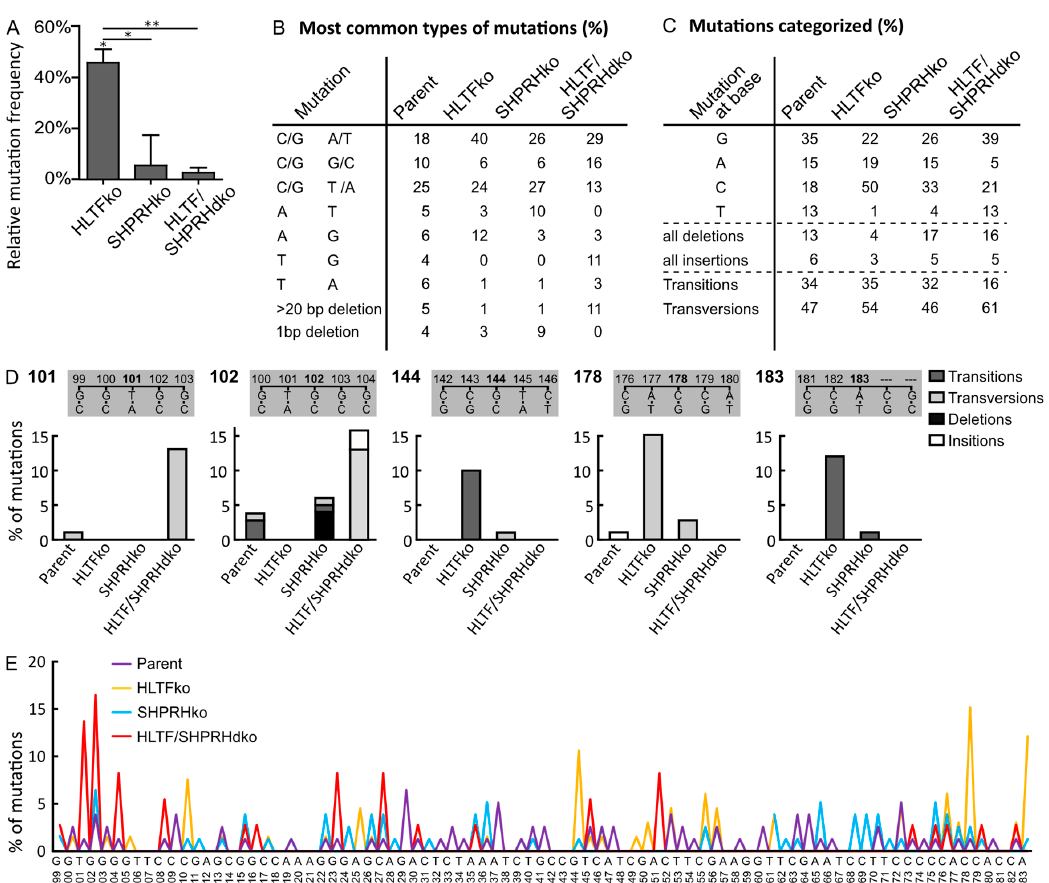
Figure 3. HLTF reduces error-prone DDT after MMS damage. ( A ) Mutation frequencies after overexpression of MMS damaged supF reporter plasmid pSP189 relative to the control (Hap1 parent cell line) with number of colonies counted for HLTF ko (n = 20,104), SHPRH ko (n = 22,294), HLTF / SHPRH dko (n = 19,130), Parent (n = 20,538), two-sided student’s t -test, * p < 0.05, ** p < 0.01. ( B ) Quantification of types of mutations from sequencing mutant colonies from ( A ) with a prevalence ≥ 5%. ( C ) Categorized mutations received from sequencing mutant colonies from ( A ). HLTF ko (n = 68), SHPRH ko (n = 78), HLTF / SHPRH dko (n = 38), Parent (n = 79). ( D ) Mutations at positions 101, 102, 144, 178 and 183 in supF gene from SupF UVB in % ( A ) with a prevalence of ≥ 10% in isolated plasmids from at least one cell line. ( E ) Mutation spectra received from sequencing mutant colonies from ( A ). HLTF ko (n = 68), SHPRH ko (n = 78), HLTF / SHPRH dko (n = 38), Parent (n = 79).